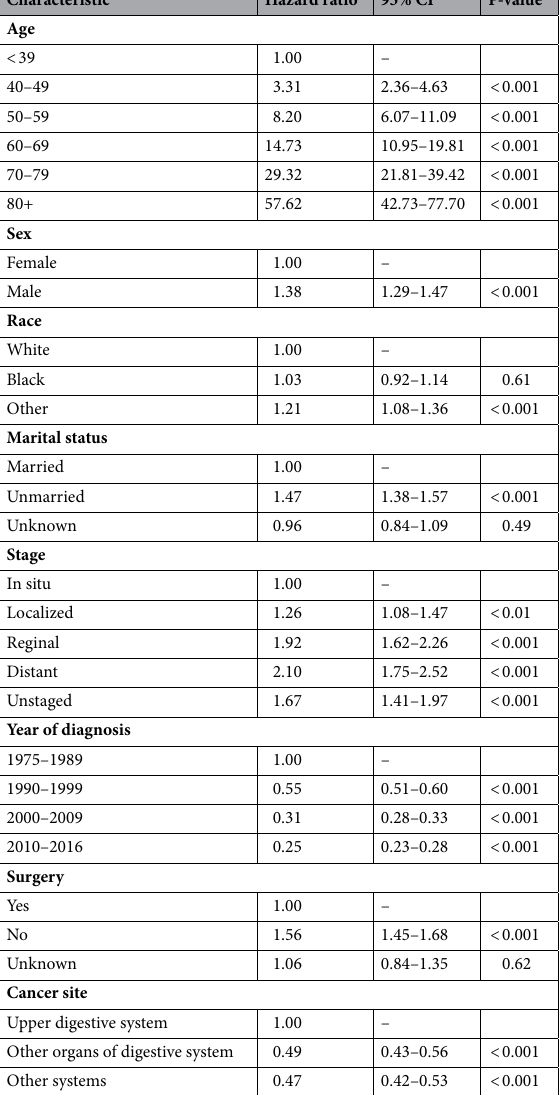
Table 3. Hazard ratios of fatal peptic ulcer among cancer